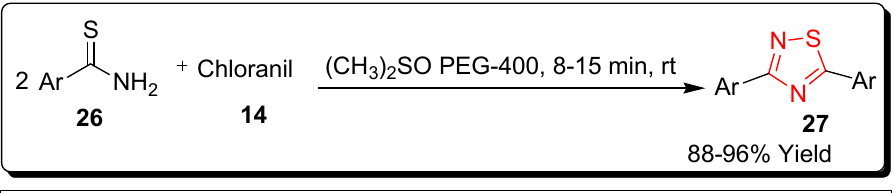
Scheme 10. Green synthesis of substituted diaryl-1,2,4-thiadiazoles 27 .